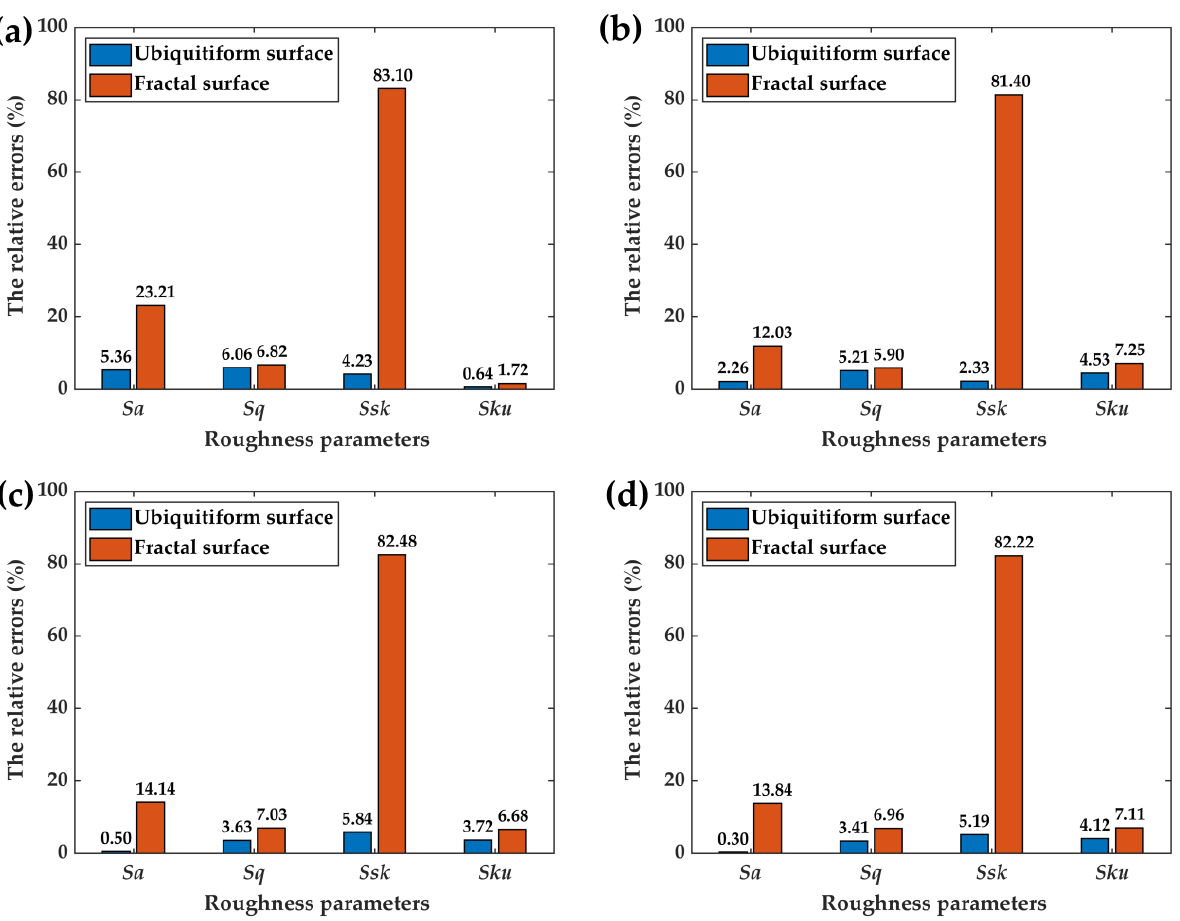
Figure 8. The relative errors of roughness parameters under different modeling methods: ( a ) Surface 1; ( b ) Surface 2; ( c ) Surface 3; ( d ) Surface 4.